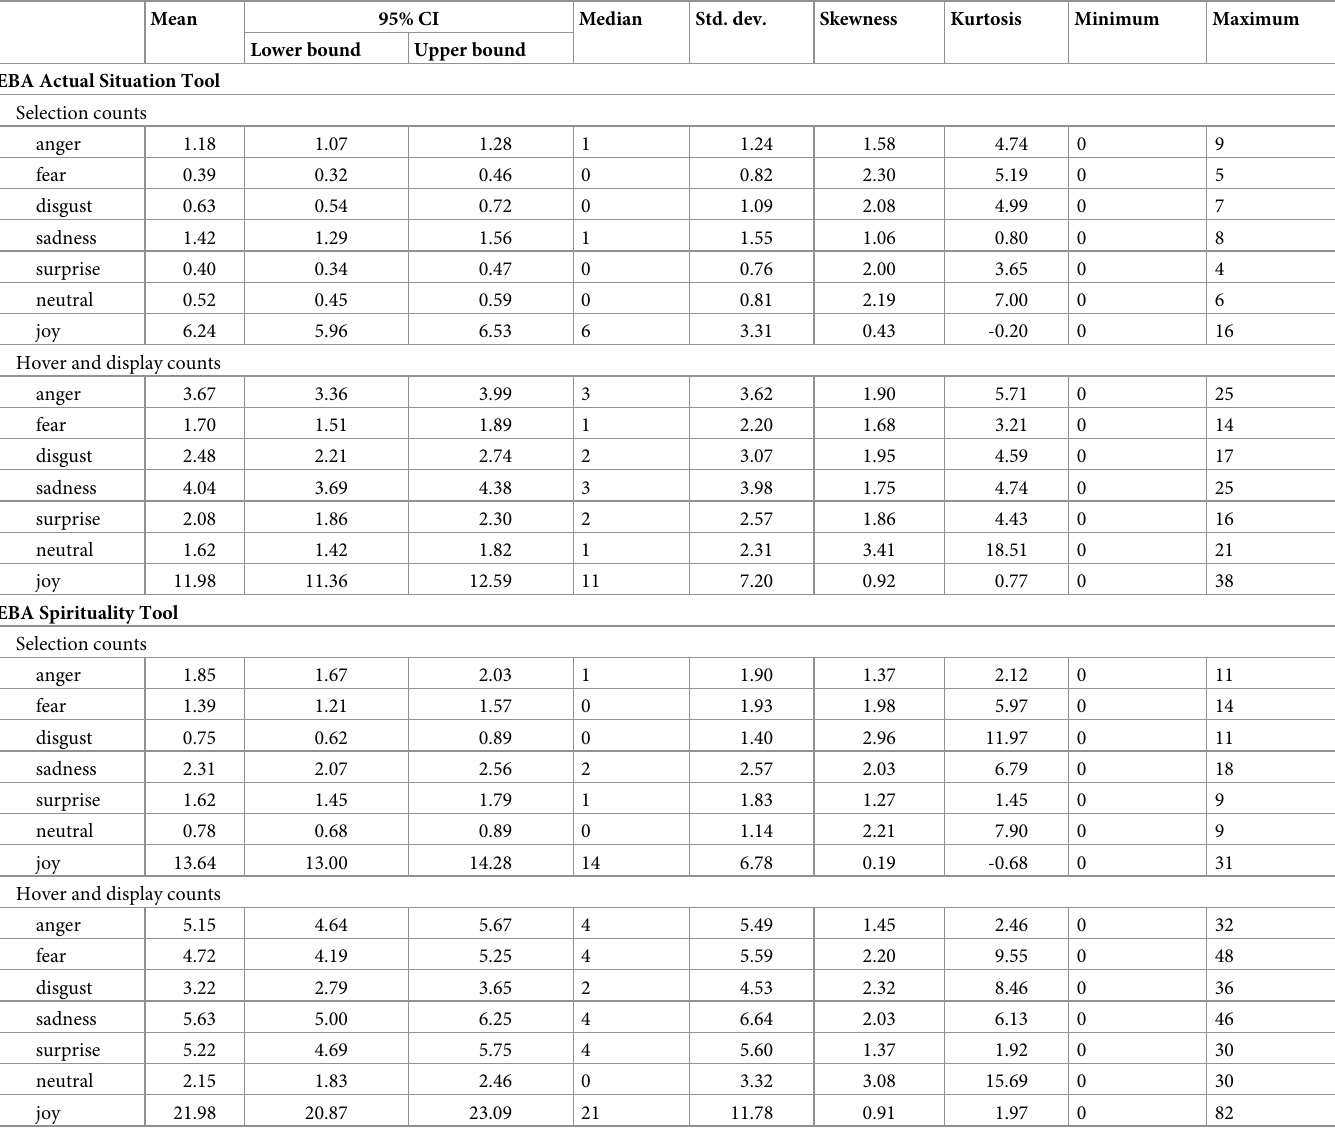
Table 4. Distribution of the scores per emotion: Means, medians, standard deviations (std. dev.) and further measures of variation. Mean 95%